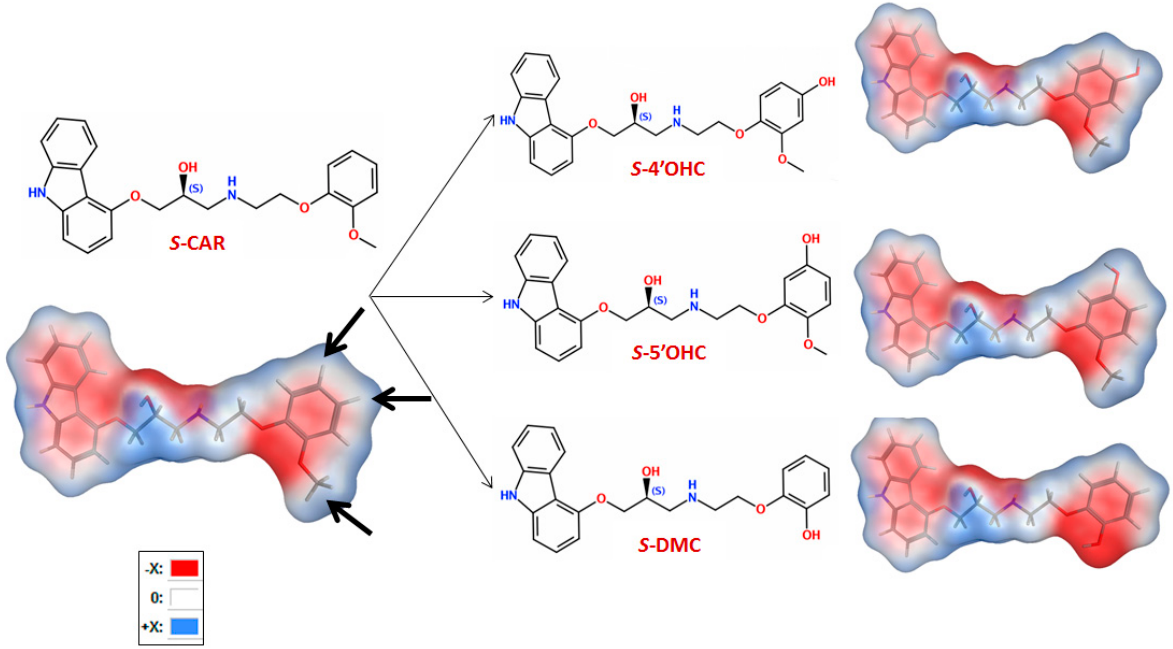
Figure 1. 2D structures of S -CAR ((-)-1-(9 H -carbazol-4-yloxy)-3-[2-(2-methoxyphenoxy) ethylamino] propan-2-ol) (left) with its more hydrophilic and active metabolites ( S - DMC , S -4 ′ OHC and S -5 ′ OHC) (right) and energy-minimized 3D structure (TPSA, with electrostatic map) of S -CAR (left) and 3D images of S -DMC, S -4 ′ OHC and S -5 ′ OHC (right).